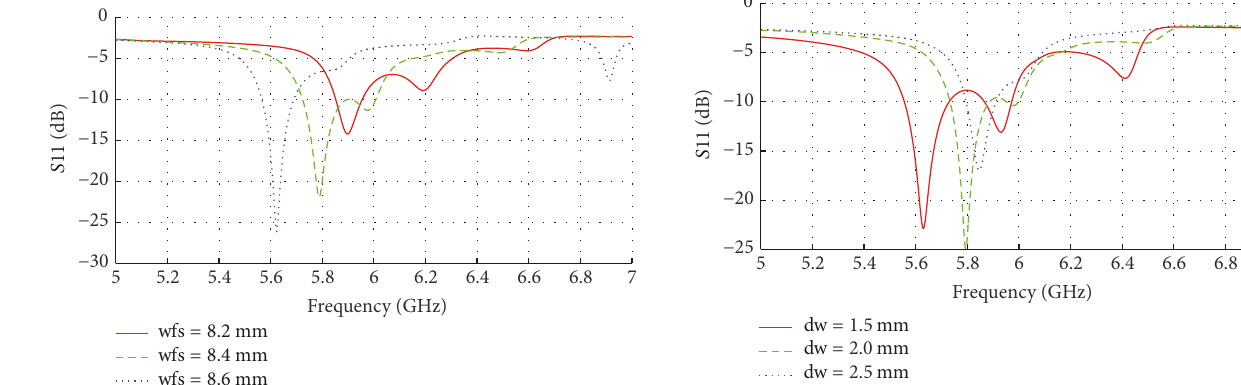
Figure 9: The optimization of length of the square ring unit.